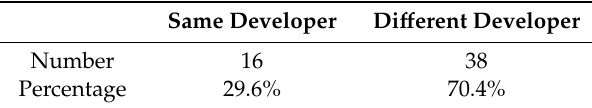
Table 8. Percentage of app with the same developer.